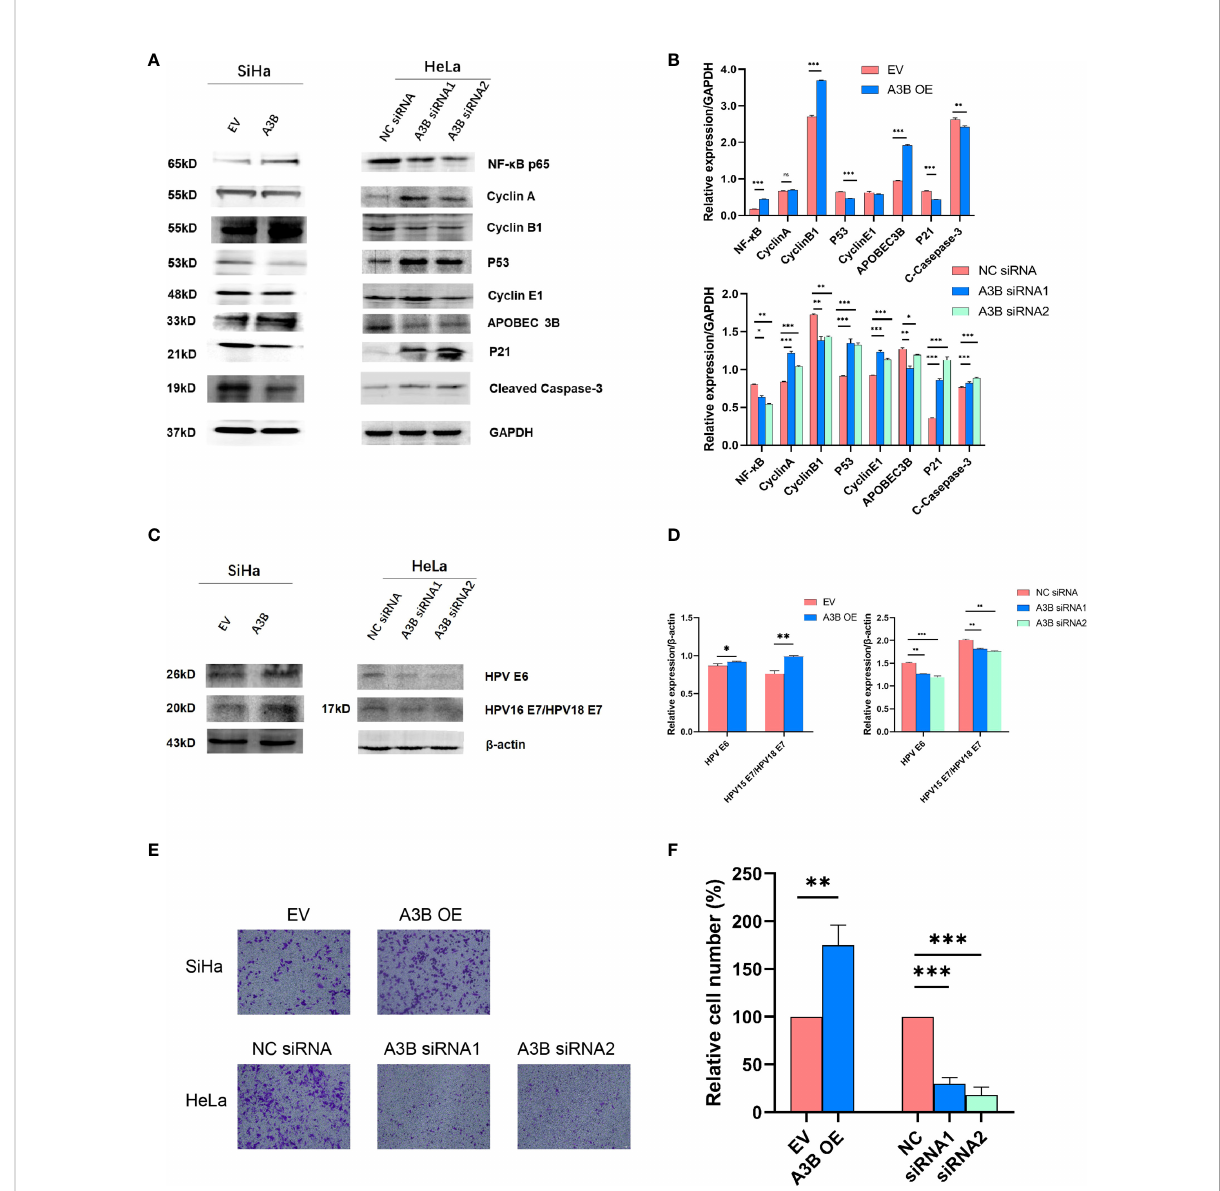
FIGURE 4 APOBEC3B is associated with cell motility and affects the p53 signal pathway. (A, C) Western blot assay results of p53 pathway-associated proteins, cell cycle proteins, E6, and E7 were affected by A3B expression levels. A3B reduced the protein levels of p53, cyclin E1, and p21 in both SiHa and HeLa cells. GAPDH was used as a loading control. (B, D) Quanti fi cation of Western blot assay data. (E) The migrating ability of HeLa and SiHa cells was associated with A3B expression levels, monitored by using a transwell migration assay. A representative image of migrated cells; 3.0 × 10 3 cells were seeded into the upper chamber. Scale bar:50 m m. (F) Statistical analysis of (E) . * p < 0.05; ** p < 0.01; *** p <